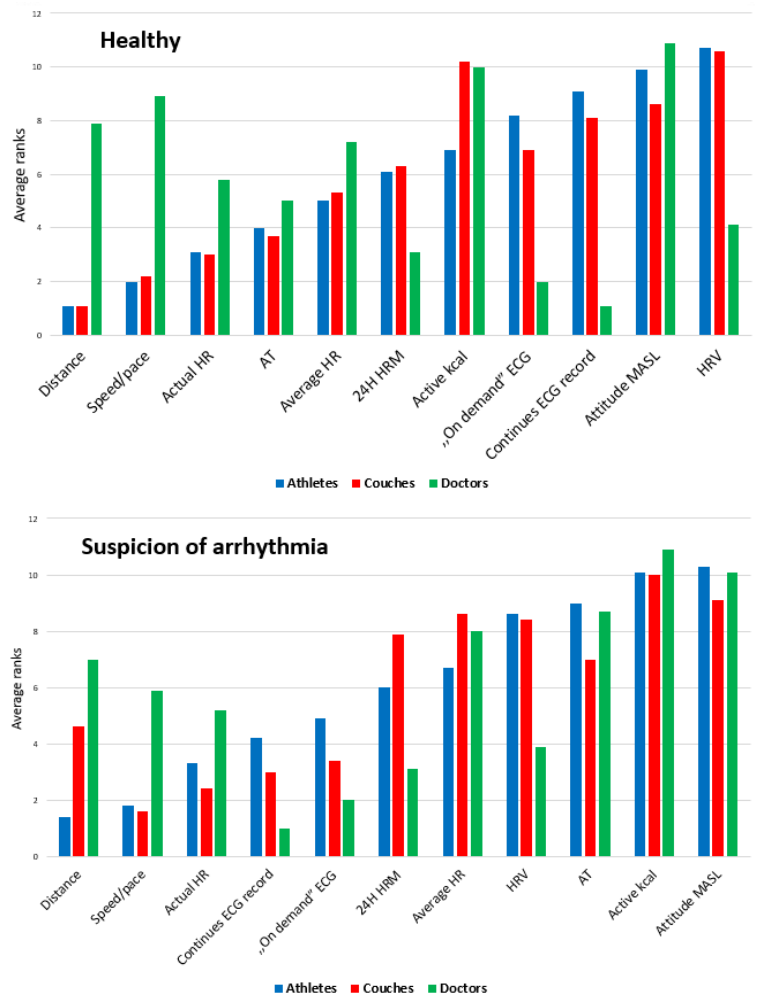
Figure 2. Cumulative results of the survey conducted among athletes, coaches, and doctors regarding the assessment of the importance of individual functions possessed by modern heart rate monitors (HRMs). Two situations are covered: standard use of HRMs and use with the hypothetical assumption of suspected athlete arrhythmia. Data are presented as rankings (mean rankings). Scale rankings 1–11 show decreasing importance of functions. AT: anaerobic threshold; MASL: meters above sea level; HRV: heart rate variability; 24H HRM: 24-h heart rate measurement.